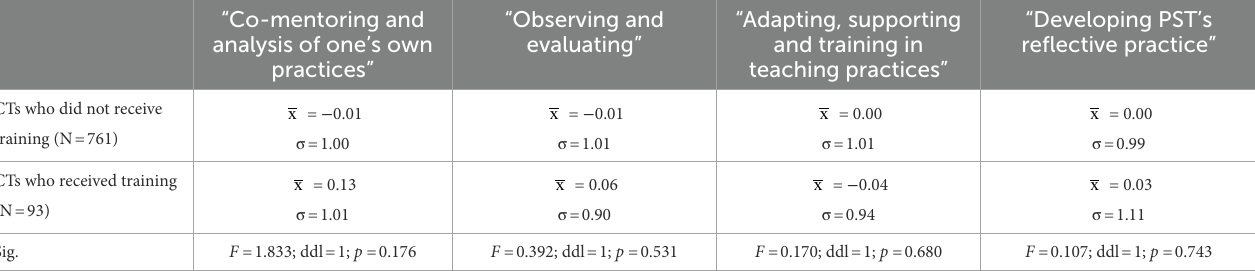
TABLE 8 Means, for each factor, of respondents divided into two subgroups according to whether or not they had received training.